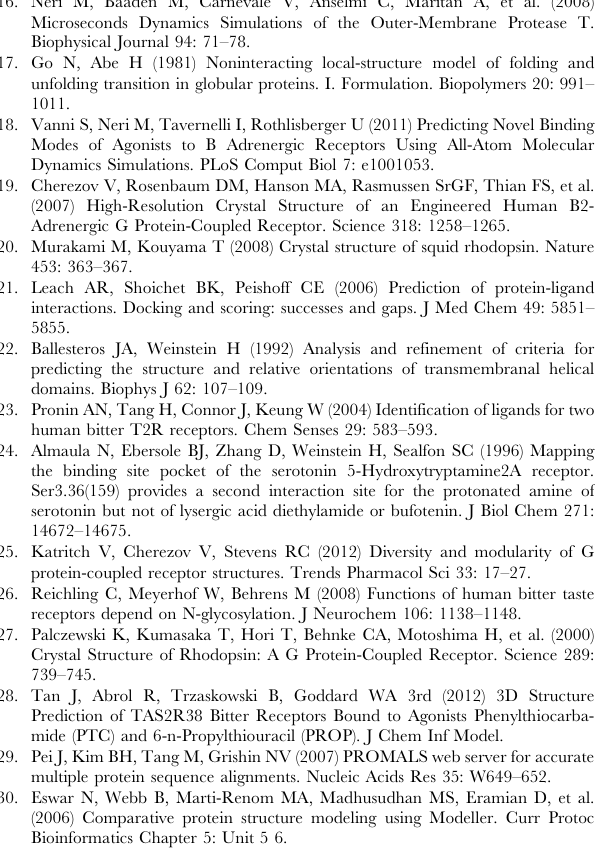
green) in the central structure of the principal clusters found in the shown. The positions of PTC and PROP agonists after the docking are shown in cyan and yellow, respectively. Table S1 List of the GPCRs for which X-ray structures are available. Their corresponding PDB codes, co-crystallized ligands, species and resolution values are indicated. The structures used in our previous work are highlighted in yellow [9]. Table S2 List of oligonucleotides used in site-directed mutagenesis. (DOC) Text S1 Supporting information. Ligand binding cavity volume calculations (calculated using the program FPocket [42,43]). Molecular docking results (DOC) Chart S1 Chemical structures of the TAS2R38 ligands used in the present work.